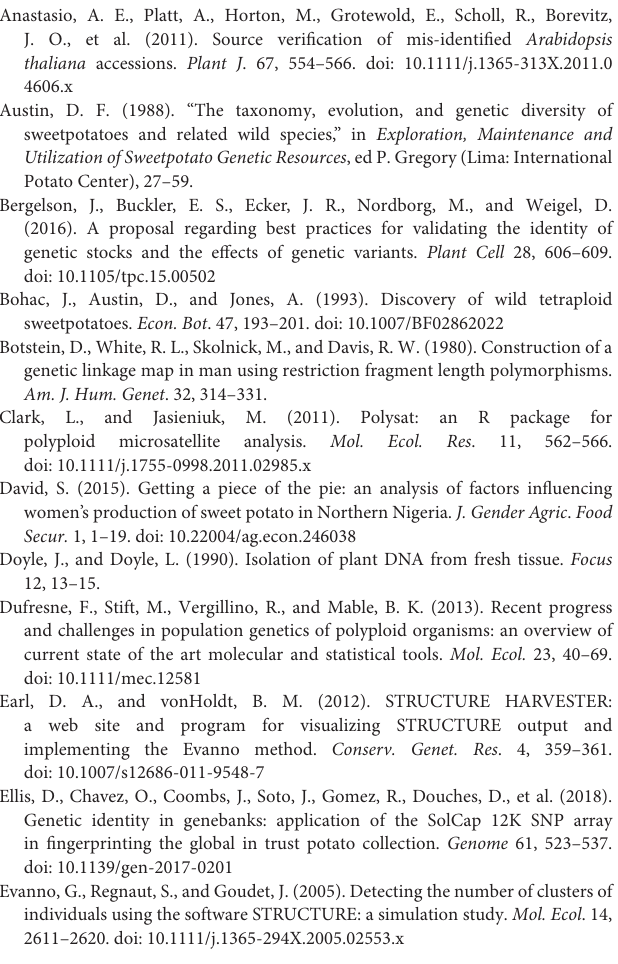
Central America. Pink = Caribbean. Africa = brown. USA = black. Blue = Argentina, Paraguay, and Brazil. Turquoise = Asia. Yellow = Oceania. Supplementary Figure 2 | A plot of pairwise genetic distances of all 5,979 accessions showing a high number of genetic duplicates in the collection. The Y-axis contains the calculated genetic distance between individuals with many pairwise combinations having 0 genetic distance. Supplementary Figure 3 | Neighbor-joining phylogeny of accessions with ≤ 95% similarity effectively removing potential duplicates or highly related samples. A total of 3,075 accessions were used to construct the dendrogram. The iTOL was employed to color code branches by country of origin or donation. Accessions from Peru are colored in purple, red are accessions from Venezuela and Colombia, Mexico, and Central America are colored green, Caribbean are colored in pink, Africa is colored brown, USA is black, blue is Argentina, Paraguay, and Brazil, turquoise is Asia, and yellow is Oceania. Supplementary Figure 4 | Delta K values for different numbers of populations in a STRUCTURE analysis. Supplementary Figure 5 | Phylogeny of 189 USDA sweetpotato accessions. The phylogeny was created from calculating a pairwise genetic similarity distance matrix and subsequently employing neighbor joining to construct the intraspecific